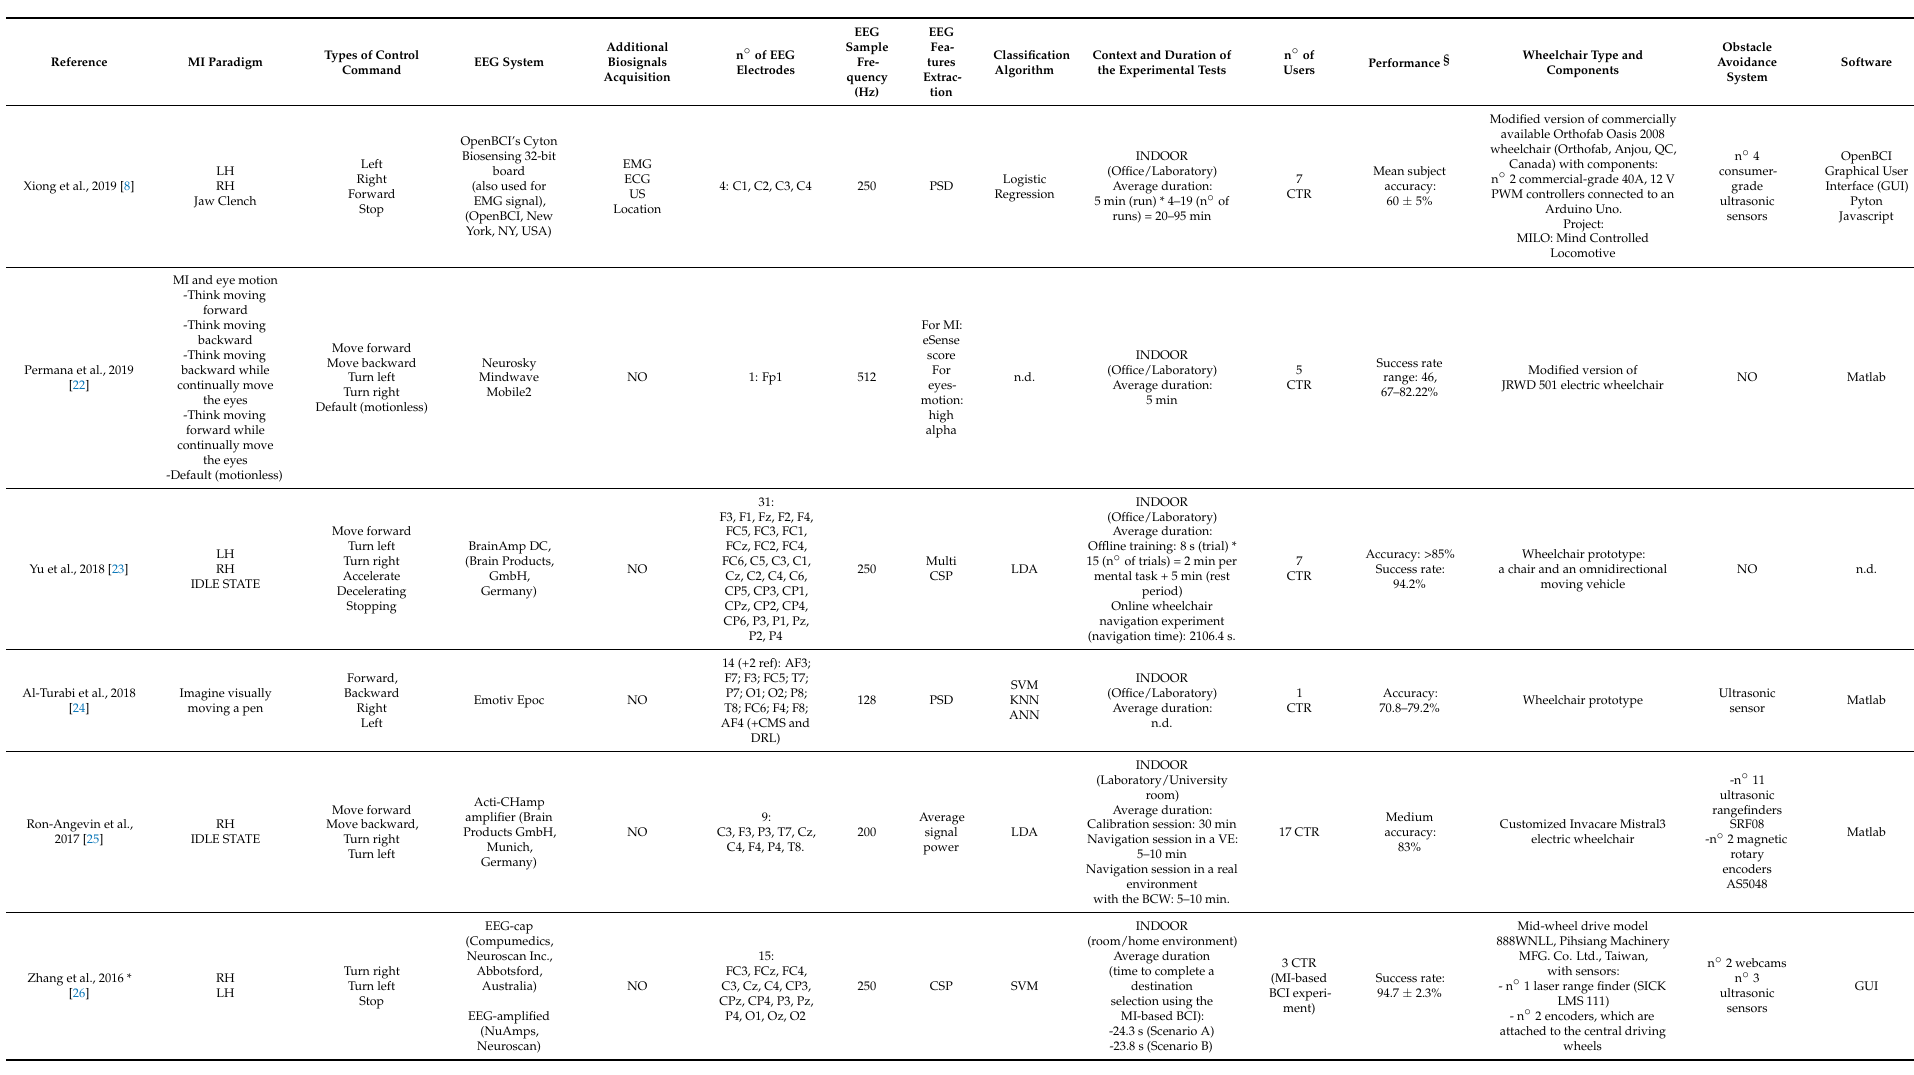
Table 1. Brain-controlled interface studies in wheelchair movement and control